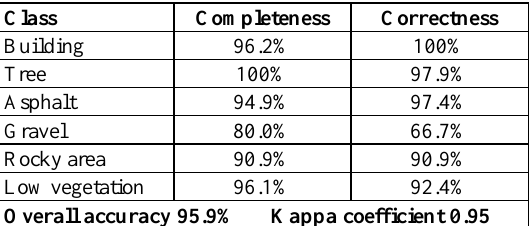
Figure 2. An example of road detection and classification results (left: multispectral ALS; right: aerial ortho image). Yellow: asphalt; orange: gravel. Dashed lines are road data from the NLS Topographic Database 2016. Aerial image © NLS